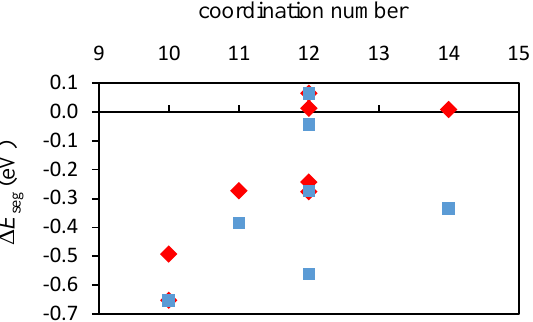
Figure 3. Segregation energies Δ E seg (eV) for P and S to the Σ9 GB as a function of the coordination number of the segregation site. S ( ■ ), P ( ♦ ).